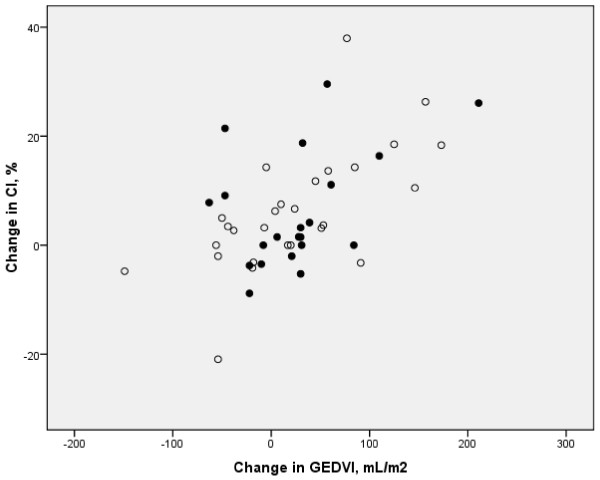
Similar changes in cardiac index (CI,%) versus changes in global end-diastolic volume index (GEDVI, mL/m2) upon fluid loading steps in patients with low global ejection fraction (open circles, r = 0.65 P < 0.001) and those with near-normal global ejection fraction (closed circles, r = 0.42 P = 0.05) during severe sepsis or septic shock.